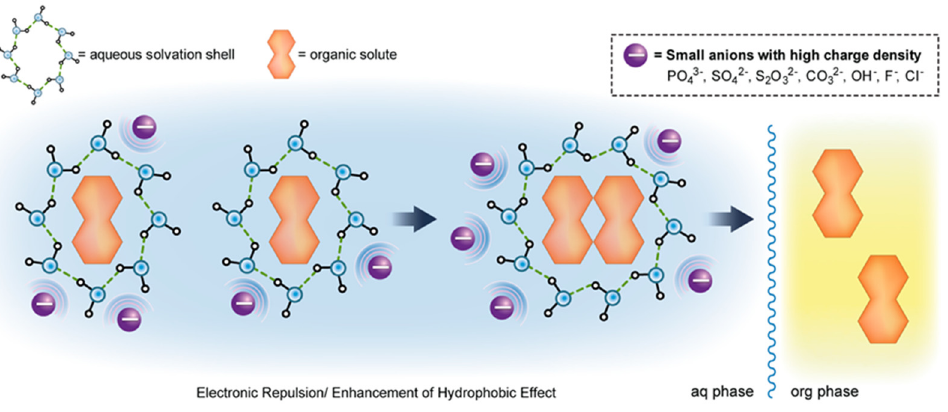
Figure 5. Molecular forces that dictate the aqueous solubility of organic solutes [33].